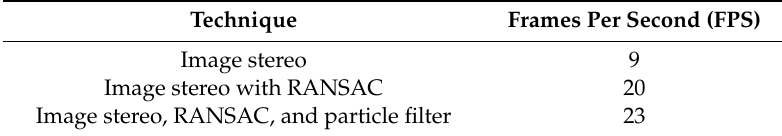
Table 5. The relation between the number of frames processed and time.